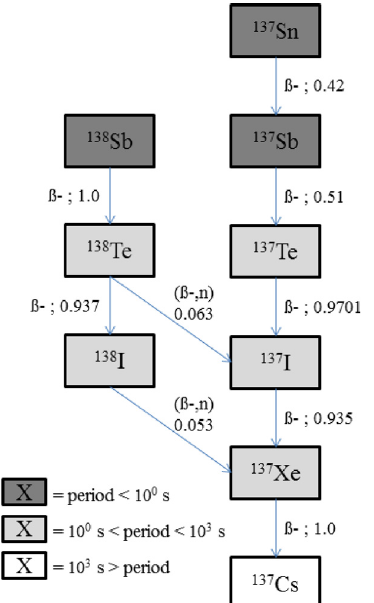
Fig. 2. Decay path of 137 Cs and associated branching ratios taken from